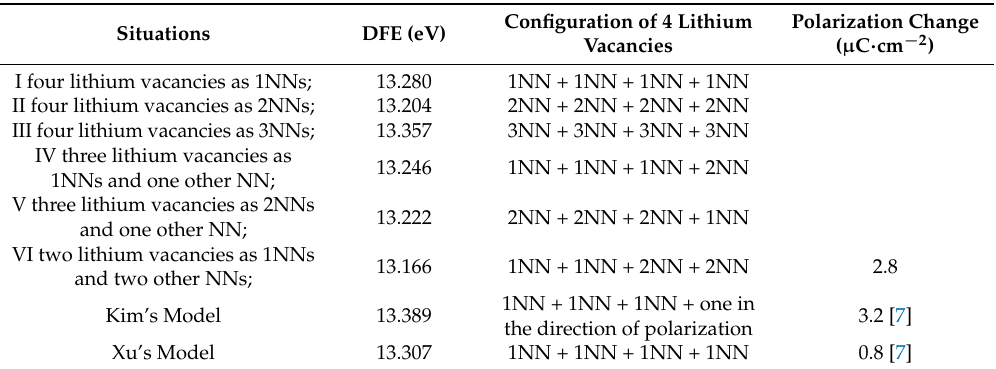
Table 1. The most stable Nb Li4+ + 4V Li − model in different situations (I–VI) with the formation energy and specific